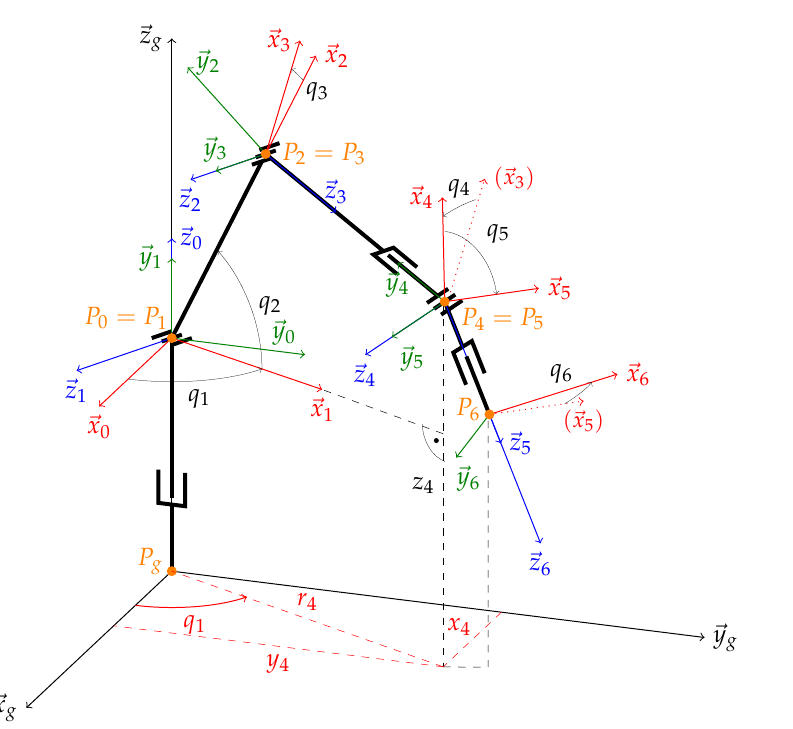
Figure 1. Kinematic structure of the robot with local coordinate systems based on the Denavit– Hartenberg principle. Table 1. Denavit–Hartenberg parameters of the chosen kinematic structure ( q 1 . . . q 6 are the joint